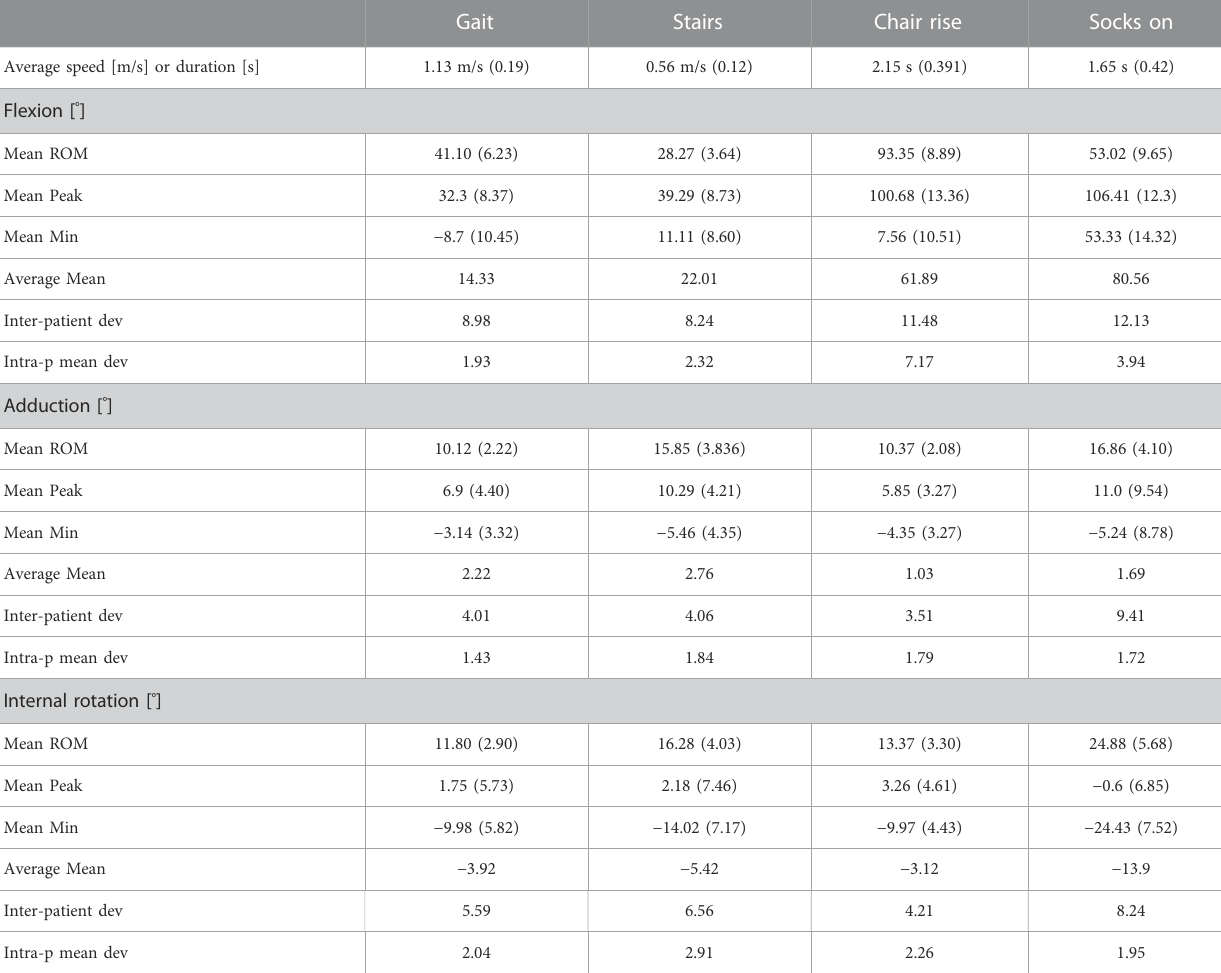
TABLE 1 Kinematic parameters extracted for 15 THA patients during four activities of daily living. Gait Stairs Chair rise Socks